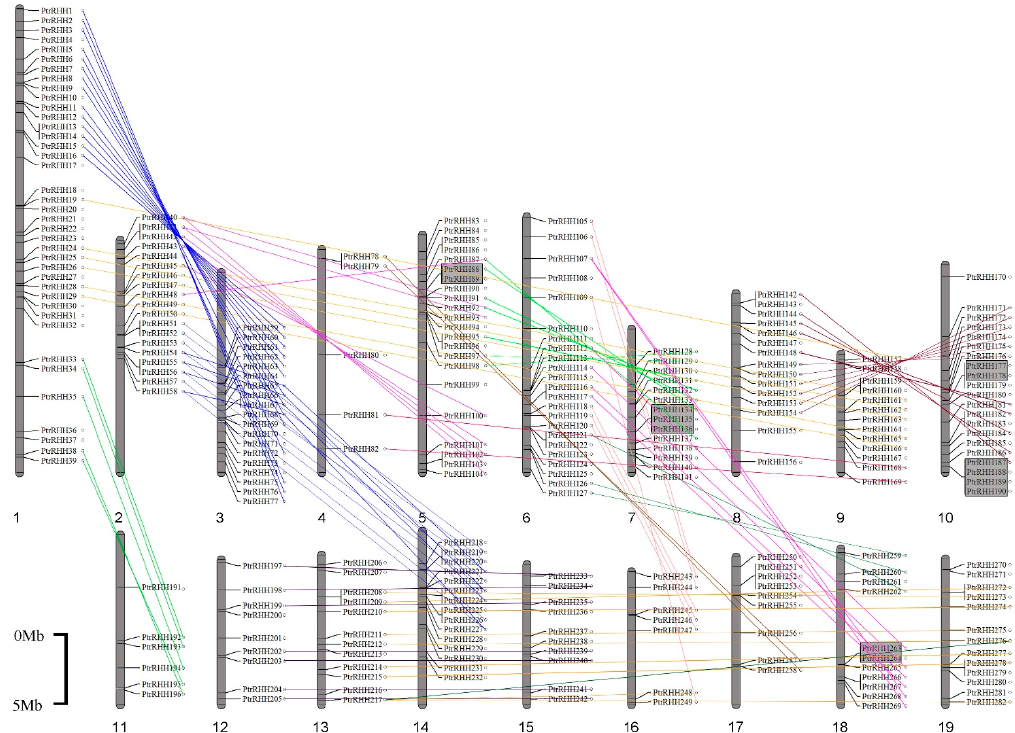
Figure 2. Gene duplications of 282 RING-H2 genes on 19 chromosomes of P. trichocarpa . The tandem gene pairs were labeled by small grey boxes. The segmental duplication genes were connected by color solid lines. The scale displayed a 5.0 Mb chromosome distance.